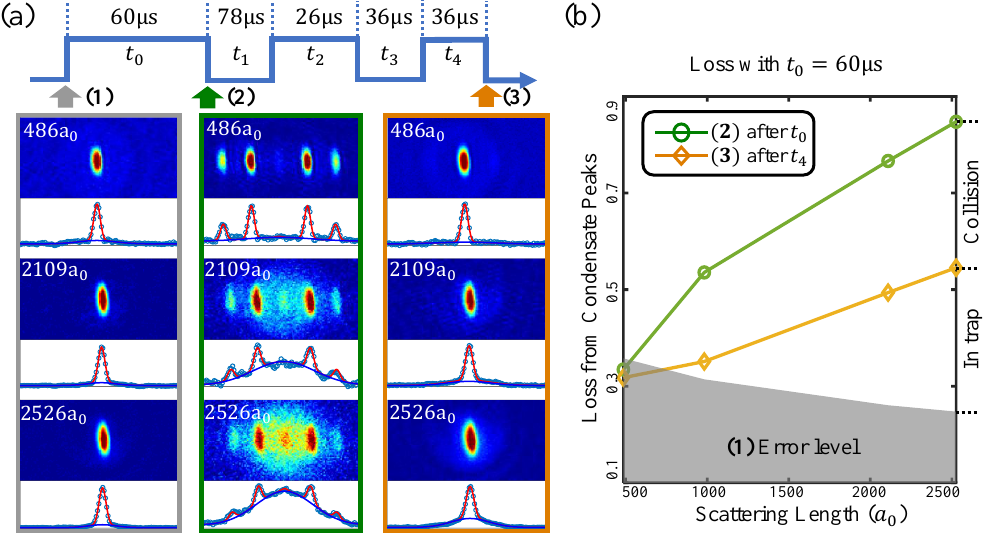
Figure 7: (a) Schematic of the pulse sequence and the corresponding absorp- tion images at different interactions. [ t = 50 E U . (b) Calculated loss plot against scattering length at different stage. The r 0 error level is calculated from the BEC images (1). Difference between line (3) and error level is the loss during the lattice pulse. Difference between line (2) and (3) is the collision loss during